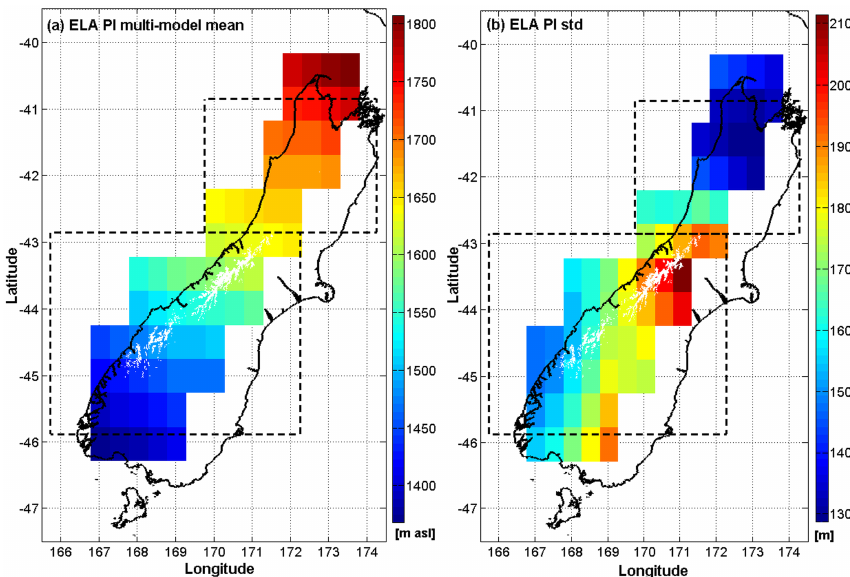
Figure 5. Spatial distribution of pre-industrial ELA in the South Island of New Zealand based on six PMIP2 simulations. (a) Mean ELA (ma.s.l.) and (b) inter-model variability of the ELA (one standard deviation). White lines correspond to actual glacier extension according to the Randolph Glacier Inventory (RGI 3.2).